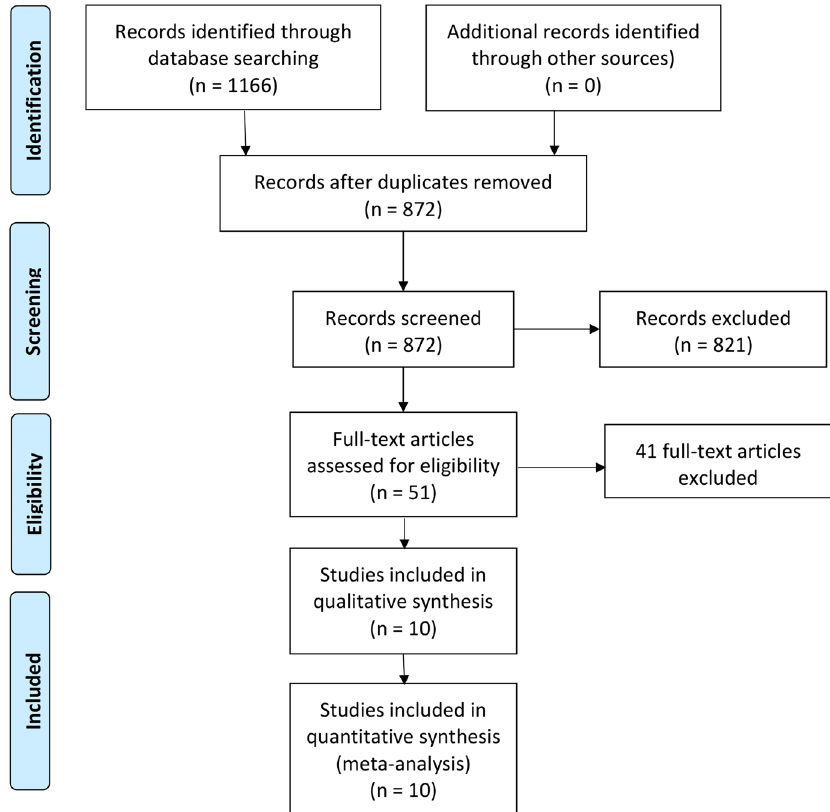
Figure 1. Flow diagram of articles selection